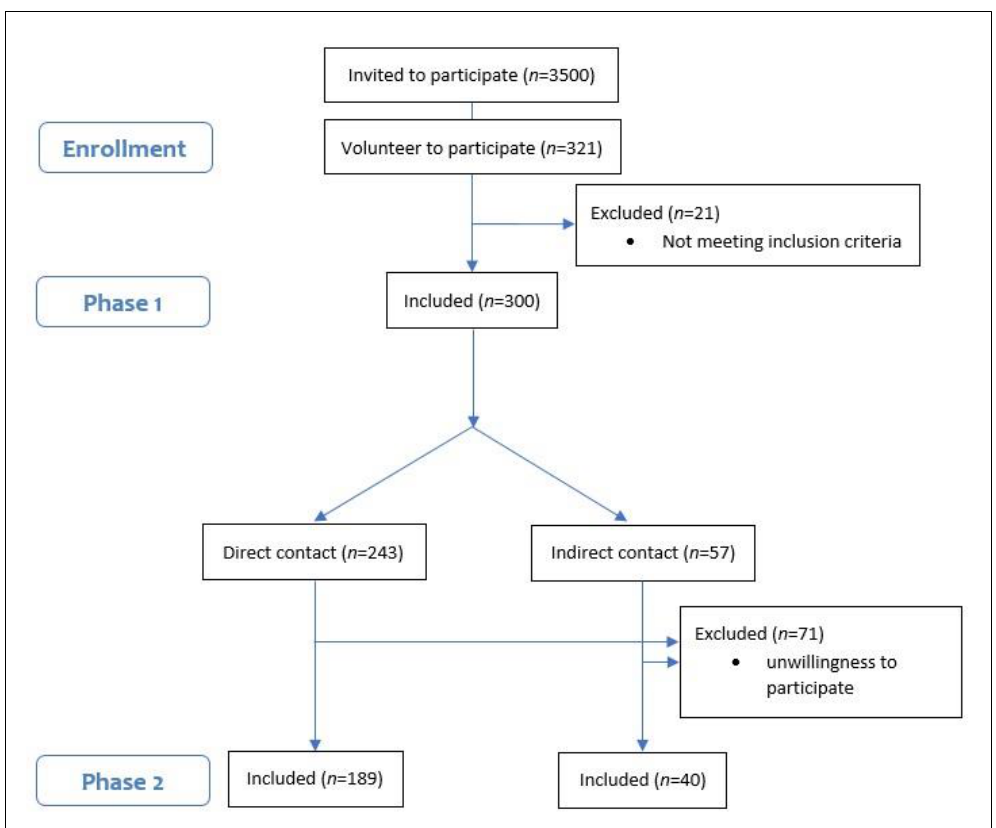
Figure 1. Flow diagram of participants.